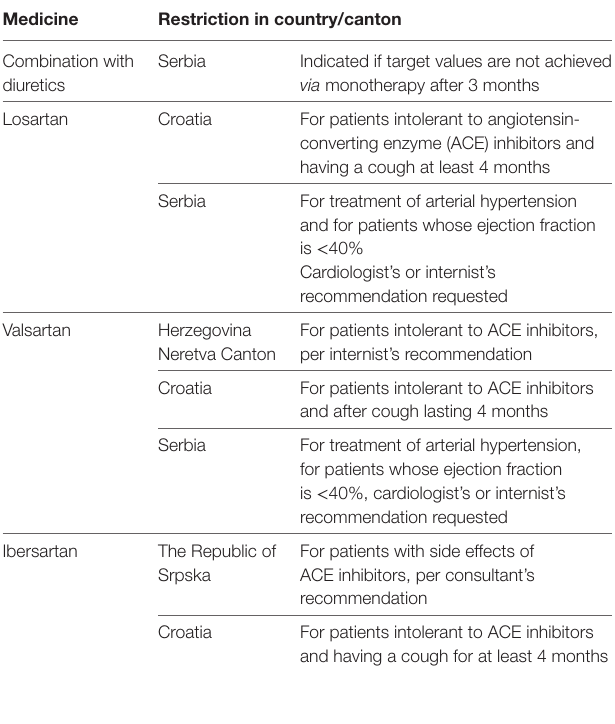
TaBle 4 | Prescribing-related restrictions for angiotensin II receptor blockers in family